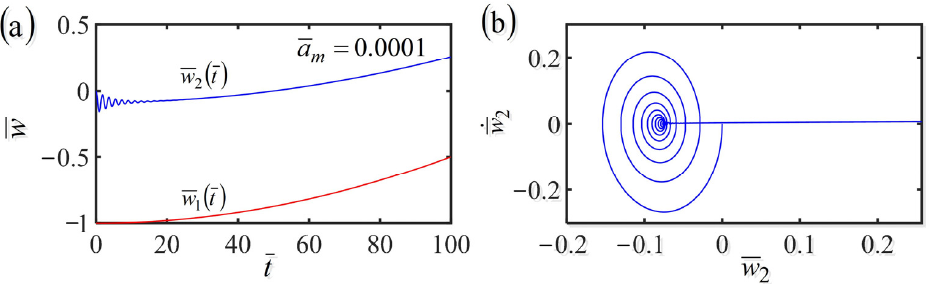
Figure 5. ( a ) Time history and ( b ) phase trajectory of the displacement of the system consisting of fiber and mass in the case of the frame at uniformly accelerated translation in a linear temperature (cid:0) (cid:0) (cid:1) (cid:1) t t field. The red line represents w 1 and the blue line represents w 2 . Whether the frame is at uniform translation or uniformly accelerated translation, the equilibrium position of the mass and the length of the LCE fiber vary with time because of the variation of contraction of the LCE fiber translating in the linear steady temperature